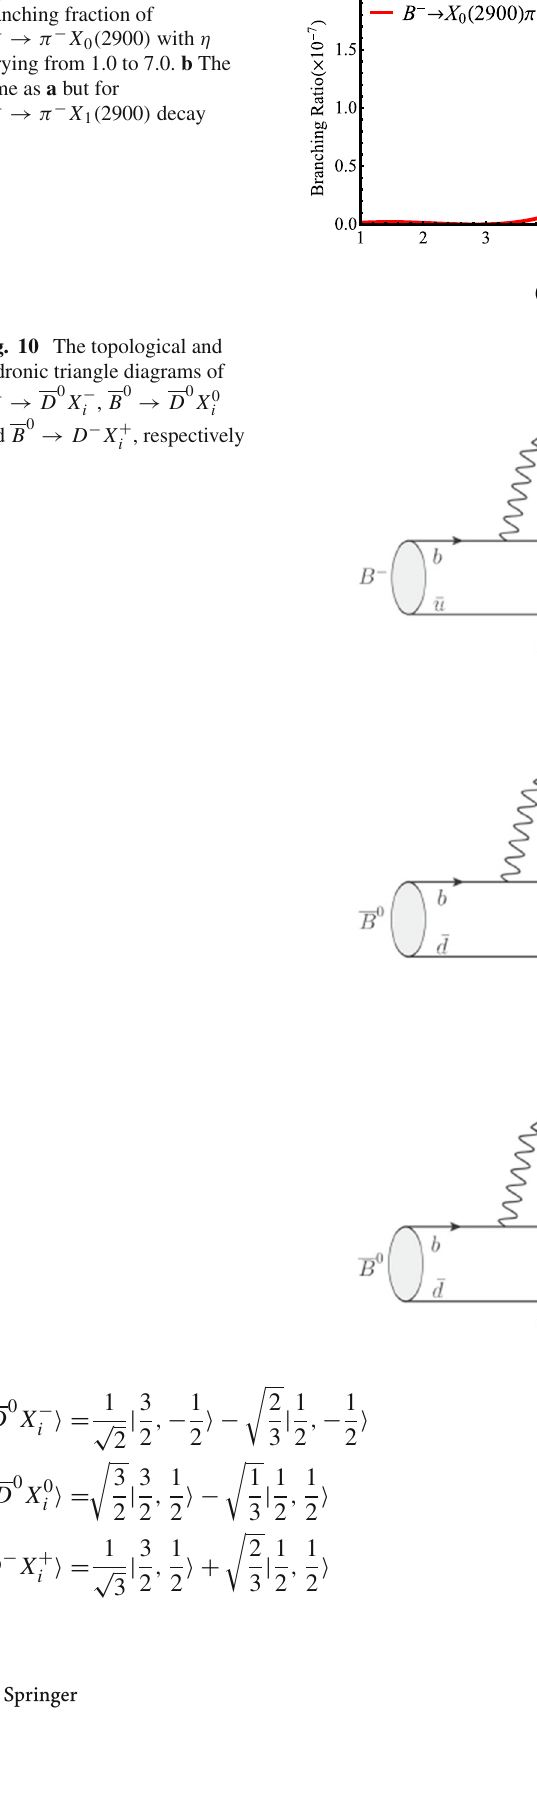
Fig. 9 a The theoretical branching fraction of B − → π − X 0 ( 2900 ) with η varying from 1.0 to 7.0. b The same as a but for B − → π − X 1 ( 2900 ) decay